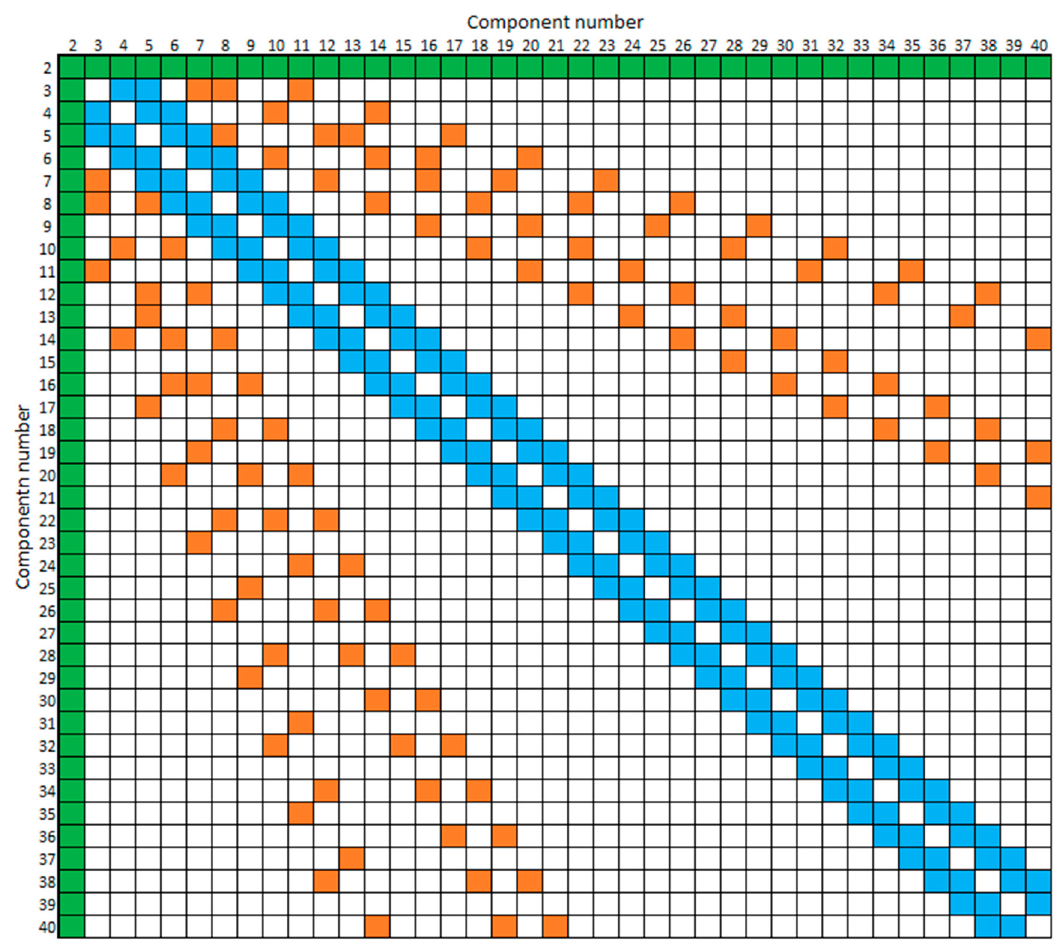
Figure 8. Correlation between component pairs with BSV. The pairs marked as white do not produce BSV, while the colored pairs produce. The different colors divide the components into three different groups; the green group includes the pairs containing the BSV-producing second component, the blue group includes the components that produce BSV with the next two lower and upper components, and the orange group includes the component pairs that are systematically scattered between the green and blue groups.